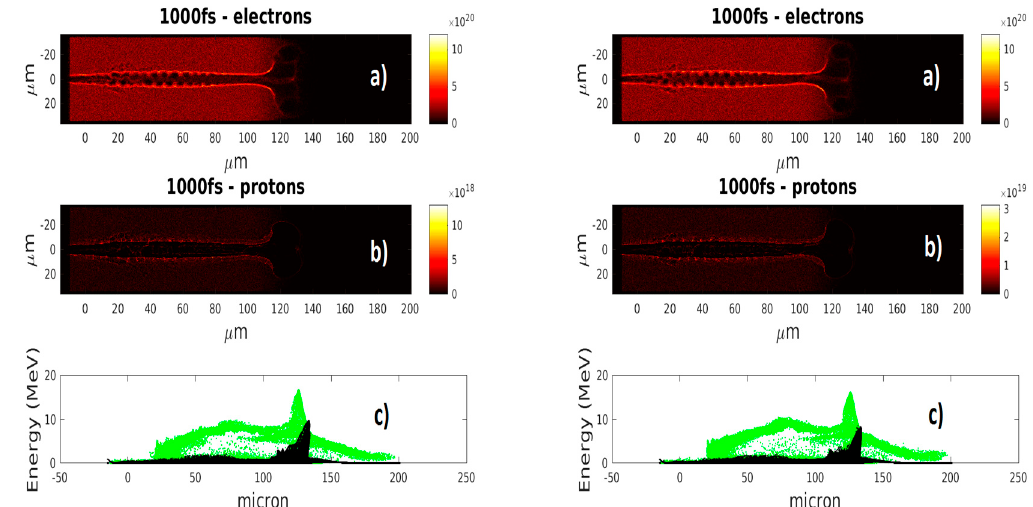
Figure 5. Shows the snapshots of the laser-plasma interactions for a fully-ionized 95%Ar–5%H ( left ) and 95%N–5%H ( right ) plasma mixture simulated by 2D PIC after 1000 fs from the pulse entry ( − 20 µ m) in the simulation box (so that the laser pulse has already left the area). The total electron density is set to be 2 × 10 20 e − / cm 3 for a simpler comparison with the case of Figure 2 (right). Also, the plasma profile considered is the same. The electrons’ (frames a ) and protons’ (frames b ) density distributions are shown with the protons’ (black) and electrons’ (green) energies versus the laser propagation direction (frames c ).